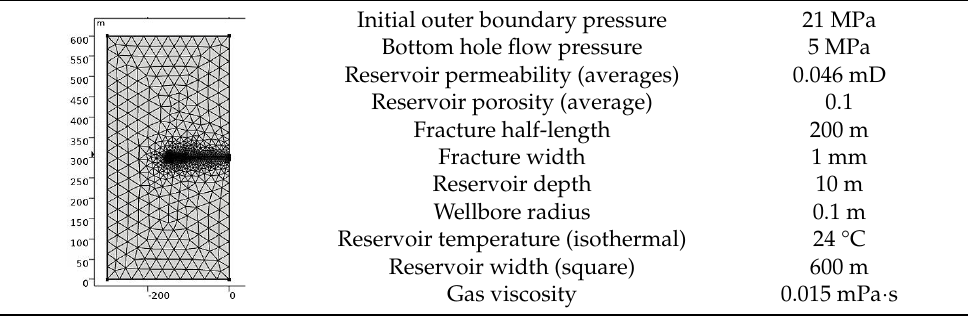
Figure 6. Pressure distribution during the fracturing development derived from the numerical model. ( a ) 30 days. ( b ) 1020 days. ( c ) 3000 days. ( d ) 5520 days. Figure 7. Verification of the numerical model with the field data. ( a ) From development pressure perspective. ( b ) From gas production perspective. 4. Mechanisms of Water Pollution in Underground Gas Reservoir 4.1. Fracturing Water Solid Solute Pollution A full-cycle fracturing development production model for water-bearing under- ground gas reservoirs based on this study, combined with COMSOL numerical simula- tion software to solve for yields under single pollution factors and under conventional storage development conditions, the gas reservoir production under conventional reservoir development conditions is also compared with the gas reservoir production under the ac- tion of a single pollution factor, and finally, the degree of pollution caused by the action of each factor on the gas reservoir production is discussed. In this study, single pollution factors refer to solid solute pollution from fracturing water, water solvent pollution from fracturing water, stress sensitivity and threshold pressure gradient. The conventional res- ervoir development conditions refer to the gas reservoir development